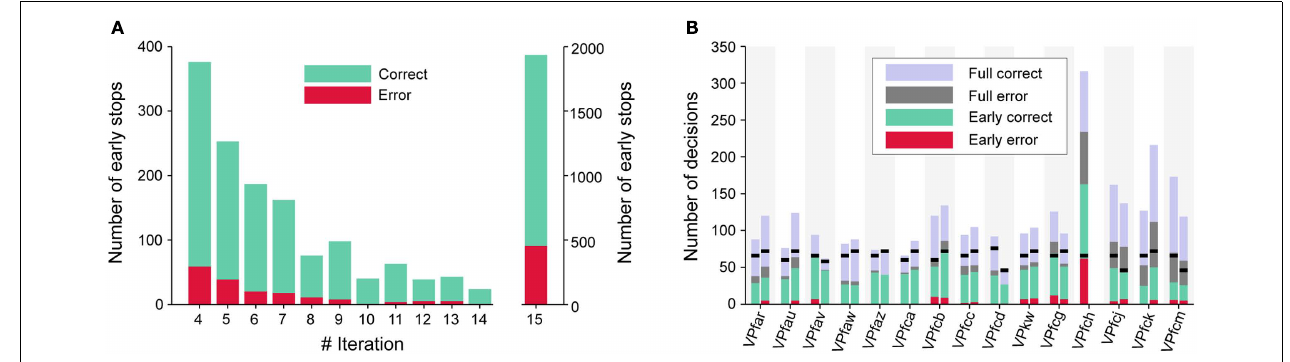
before the 15th iteration.The same data is plotted in (B) , but separately for each subject and for sentences 2a and 2b.The black markers indicate the minimum number of selections necessary for writing a sentence. Subject VPfch did not perform sentence 2b.